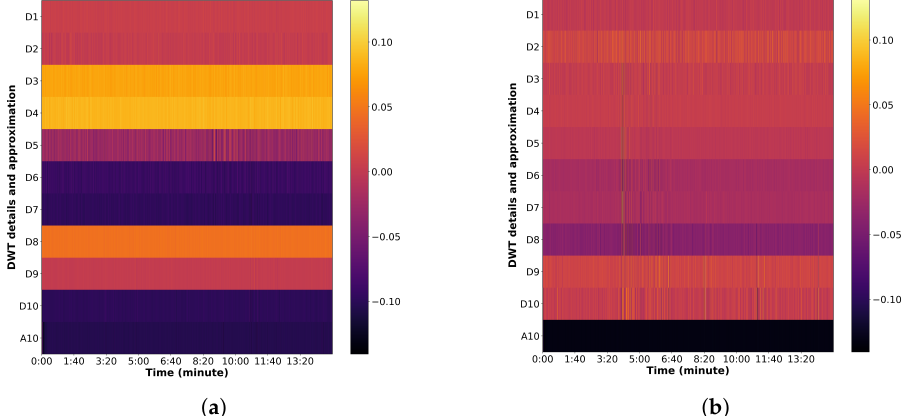
Figure 9. Comparison of the changes in distribution of the DWT detail and approximation compo- nents ( a ) without and ( b ) with the presence of train rail squealing